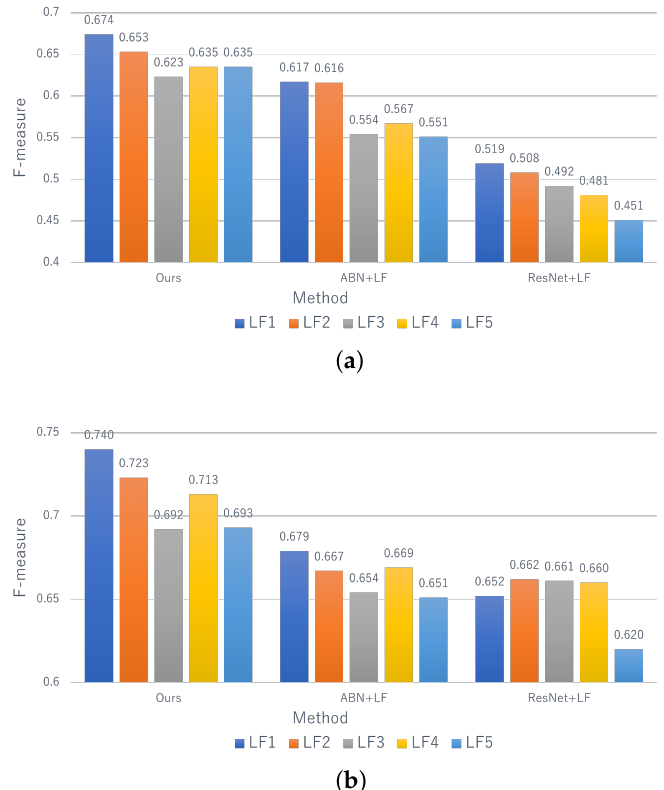
Figure 10. Verification of estimation performance using different late fusion. ( a ) Efflorescence and ( b )